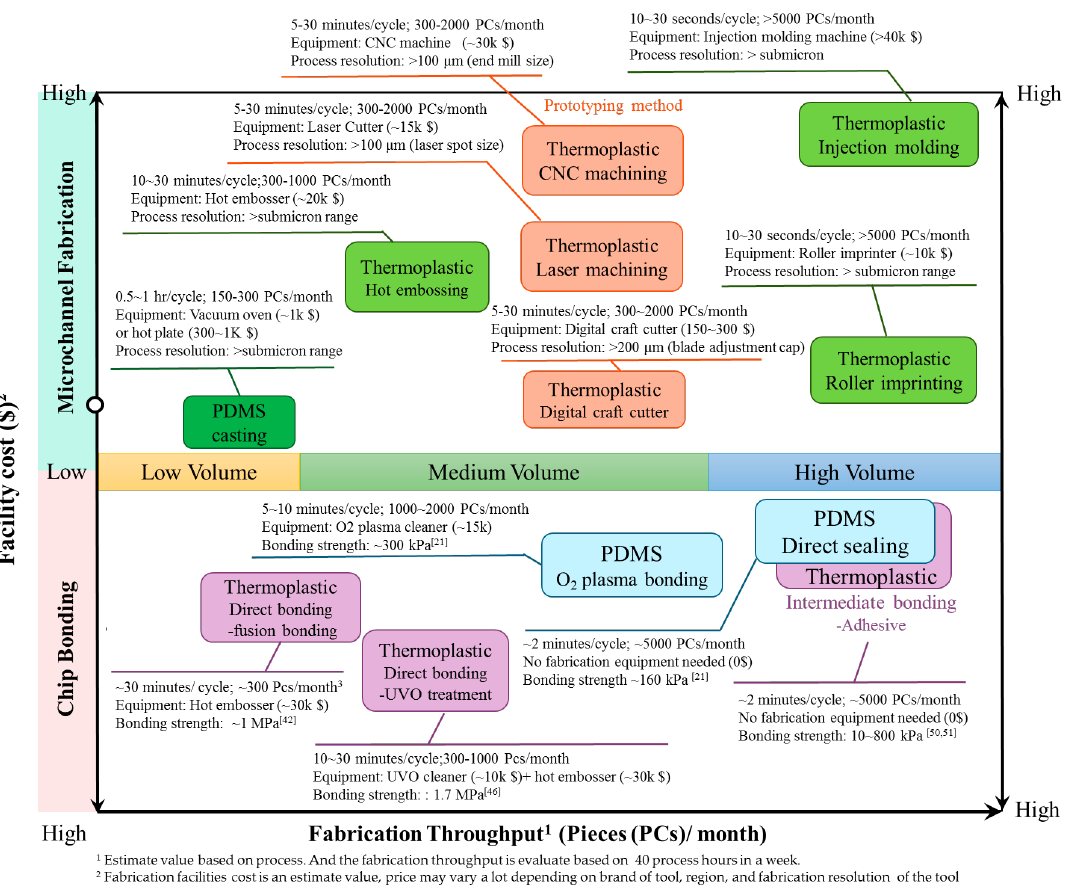
Figure 3. Estimation of fabrication throughput ( x -axis, PCs/month) and facility cost ( y -axis, in US dollars) of critical polymer microfabrication procedures.